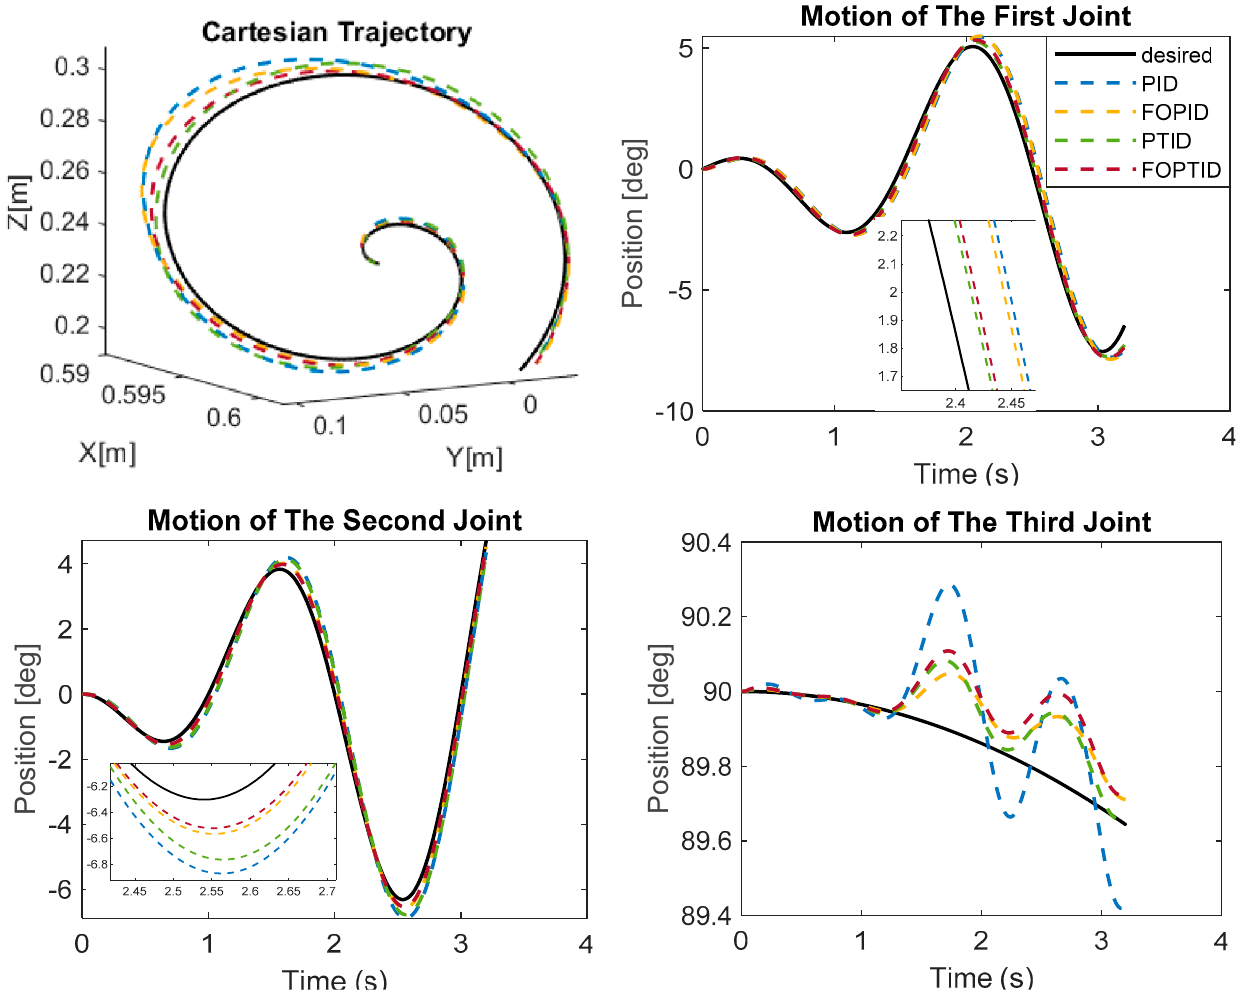
Figure 12. Trajectory tracking performance in task and joint space for PID, FOPID, PTID and FOPTID controller schemes.